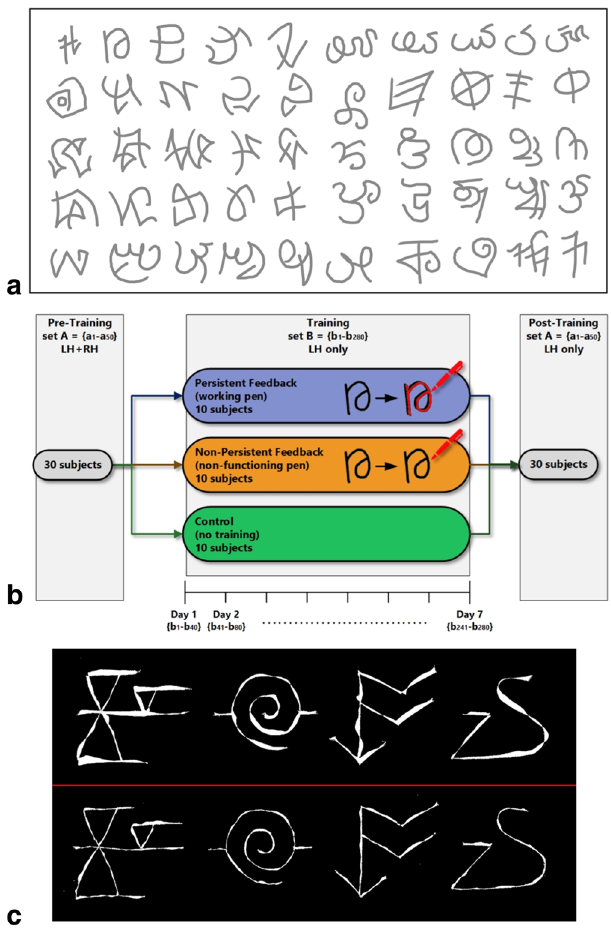
Figure 1. Study methods. ( a ) Sample patterns subjects were asked to trace in the experiment. ( b ) 30 subjects participated in a pre-training session, where they were asked to trace patterns in set A with their left and then right hand. The subjects were then randomly split into three training groups. Participants in the Persistent and Non-Persistent Feedback groups were instructed to trace with their non-dominant left hand 40 patterns a day from set B for 7 consecutive days (patterns across training days were non-overlapping). The Control group was asked not to trace during training. All 30 subjects then performed a post-training tracing session over the original patterns from set A using their left hand. ( c ) The upper panel shows difference in area between four pre- training tracings and the corresponding reference patterns, while the lower panel shows the differences between post-training tracings and the reference shapes, all for the same